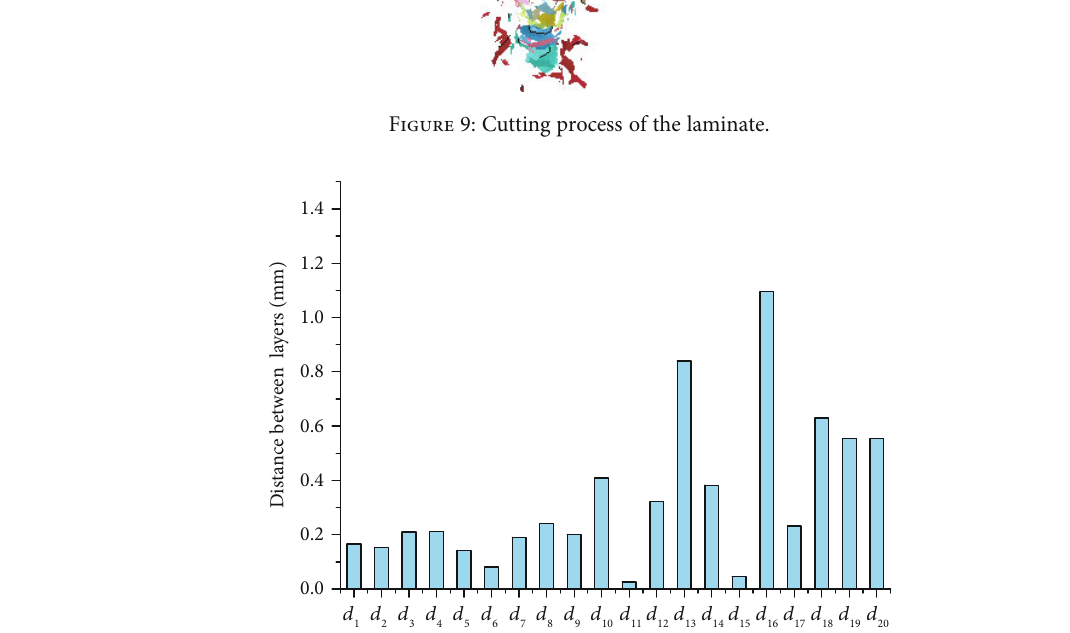
Figure 10: Delamination between